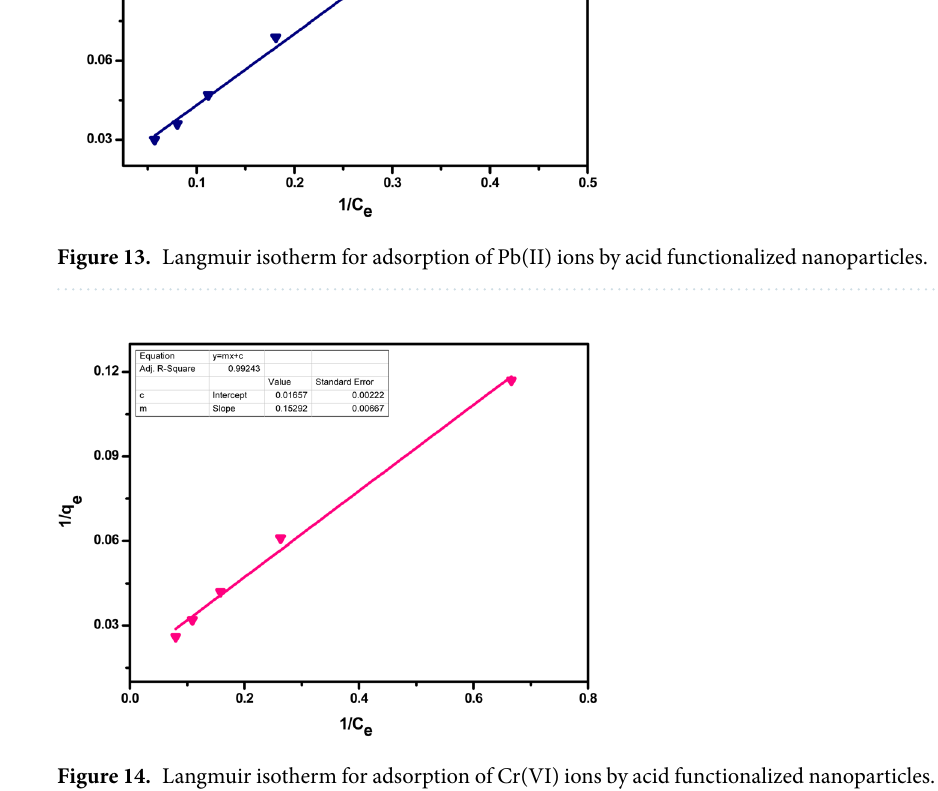
Figure 14. Langmuir isotherm for adsorption of Cr(VI) ions by acid functionalized nanoparticles.